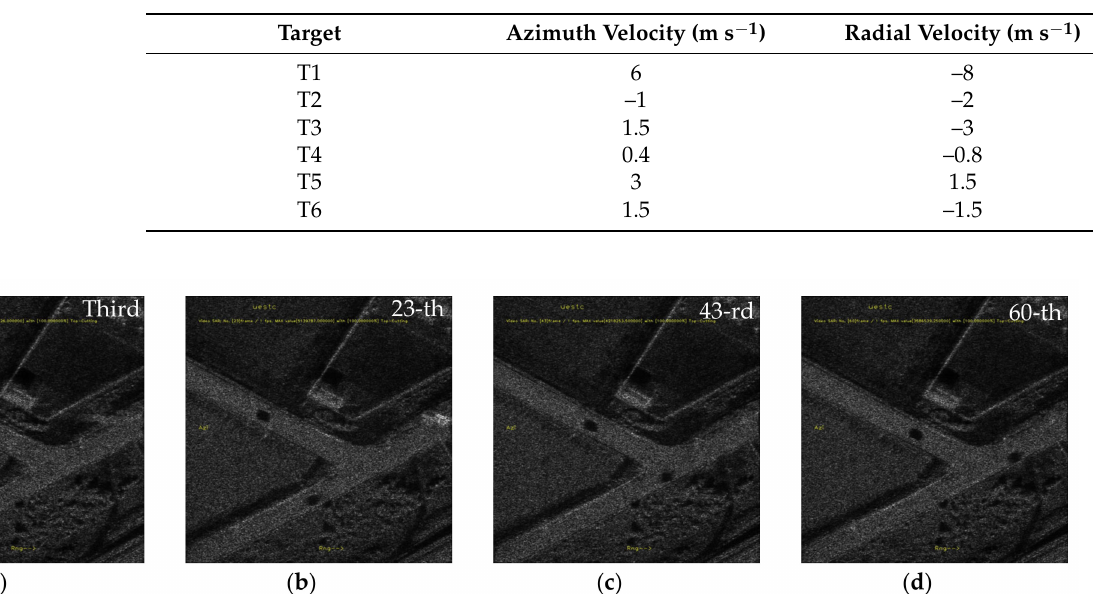
Table 2. The velocity of the moving targets in the simulated Video-SAR data.